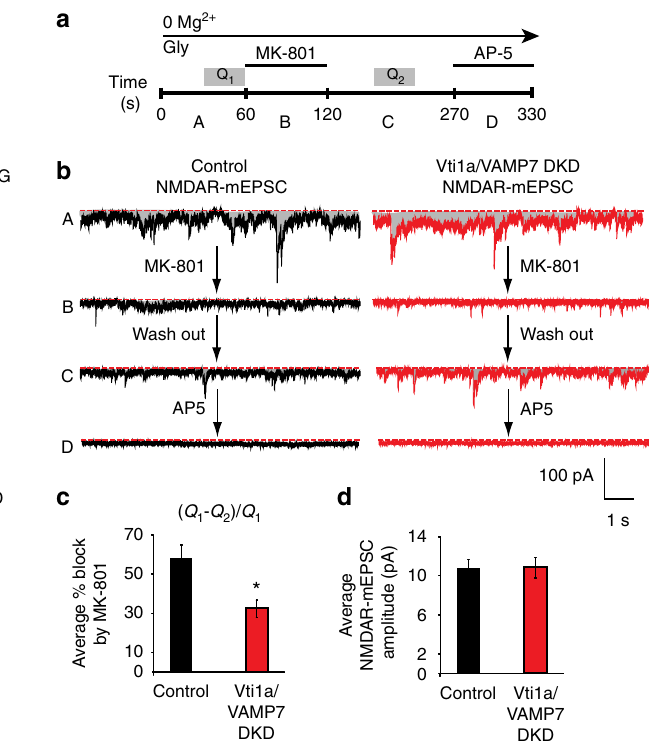
Figure 2 | Vti1a- and VAMP7-contaning synaptic vesicles regulate tonic NMDA receptor (NMDAR) activation. ( a ) Diagram showing the experimental strategy. Basal NMDAR-mEPSCs were recorded from cultured rat hippocampal neurons in the absence of extracellular Mg 2 þ and the presence of the co-agonist, glycine (10 m M). Neurons were then incubated with the use-dependent and slowly reversible NMDAR antagonist MK-801 (10 m M) for 1min and subsequently washed for 1.5min. AP-5 (50 m M) was added at the end of the experiment to confirm that the mEPSCs originated from NMDARs. Q1 and Q2 indicate regions where total charge transfer was measured and used for analysis of percent NMDAR blockade by MK801. A-D corresponds to regions containing the sample traces shown in b . ( b ) Sample NMDAR-mEPSC traces from control and vti1a/VAMP7 DKD neurons subjected to the indicated treatments shown in panel a . ( c ) Quantification of percent block of the NMDAR by MK-801 in control and vti1a/VAMP7 DKD neurons. MK-801 was significantly less effective in blocking NMDAR activity in vti1a/VAMP7 DKD neurons compared with control (control: n ¼ 11 recordings from three independent cultures; vti1a/VAMP7 DKD: n ¼ 9 recordings from three independent cultures; P ¼ 0.01). ( d ) Average basal NMDAR-mEPSC event amplitudes were unchanged in vti1a/VAMP7 DKD neurons compared with control neurons from data analysed in c ( P ¼ 0.97). The total charge transfer as a cumulative measure of NMDAR activity was quantified from a 30-s period before and after MK-801 application (Q 1 and Q 2 in Fig. 2a). The remaining activity after MK-801 was then subtracted from the baseline activity to calculate the amount of activity blocked by the treatment, and this number was then divided by the baseline activity to calculate the percentage of activity blocked by MK-801 (Fig. 2c). MK-801 treatment itself significantly reduced NMDAR-mEPSC activity in both control and vti1a/VAMP7 DKD neurons, consistent with earlier results from our group 17 ; however, vti1a/VAMP7 DKD neurons retained more activity than control neurons during the washout phase and, therefore, experienced reduced block (Fig. 2b,c). Under these